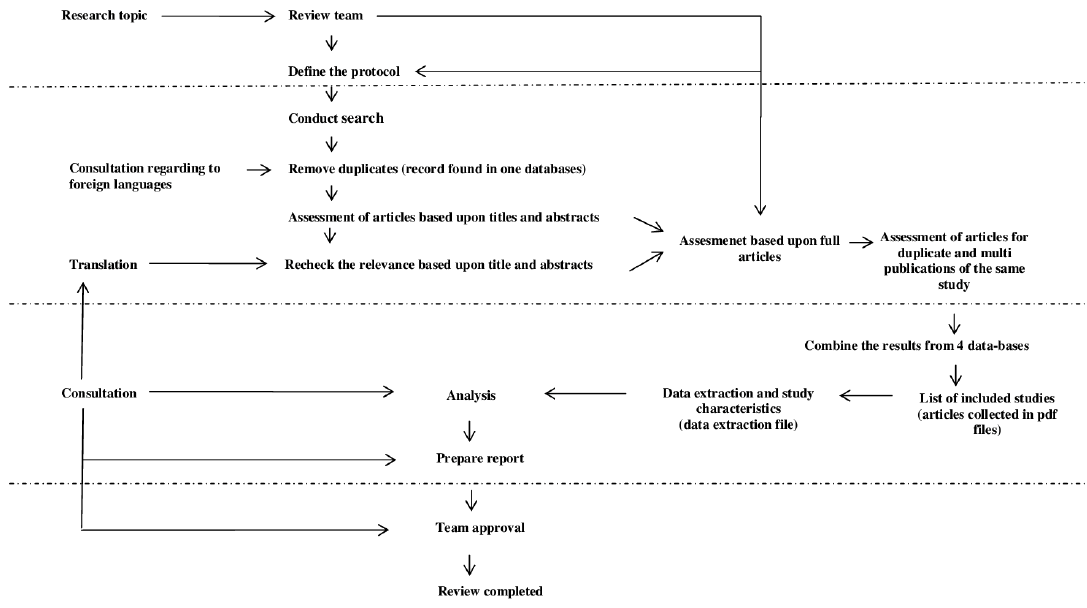
Figure 1. Process flow sheet.